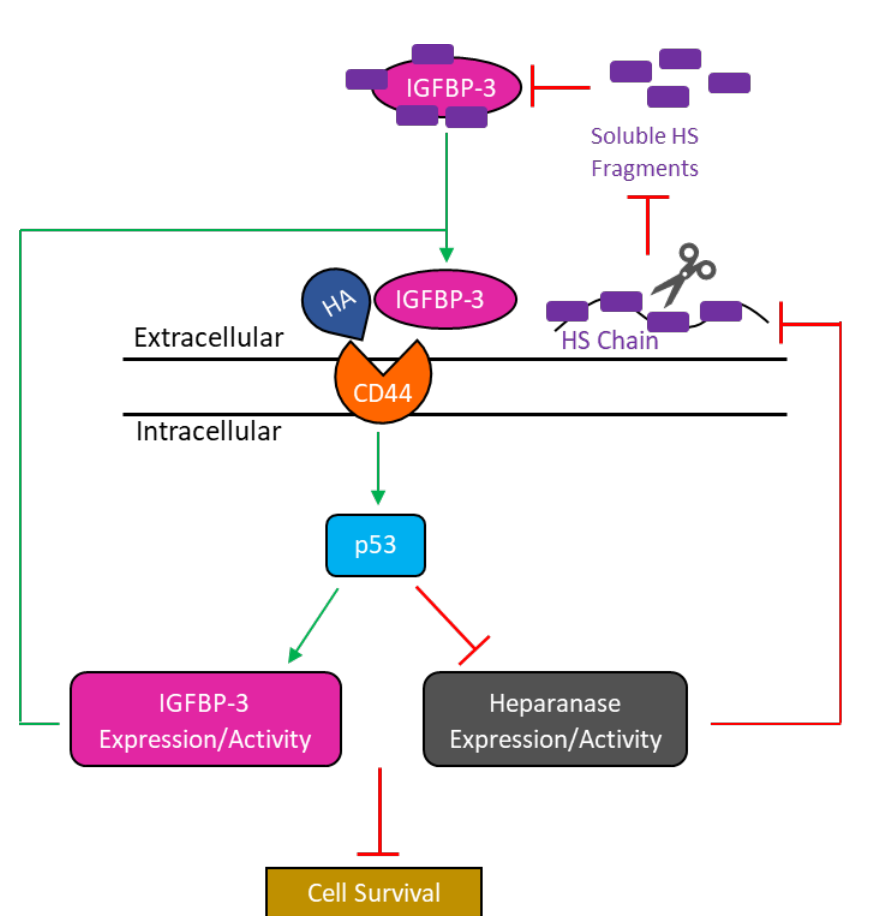
Figure 8. Representation of the main hypothesis and findings from this study. Binding of IGFBP-3 to HA blocks HA–CD44 signaling leading to p53 activation which in turn results in increased IGFBP-3 levels. IGFBP-3 is now able to continue disrupting HA–CD44 signaling further increasing its own levels. Increased p53 activation resulting from disruption of HA–CD44 signaling by IGFBP-3 also leads to decreased heparanase levels and activity, blocking the enzyme’s ability to cleave cell-surface HS chains, decreasing soluble HS fragments, and formation of the IGFBP-3-HS complex. IGFBP-3 not bound to HS is now able to bind HA disrupting HA–CD44 signaling decreasing cell survival. Green lines/arrows indicate activation while red lines indicate inhibition.